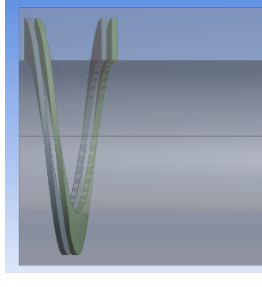
Figure 13. Double blades.